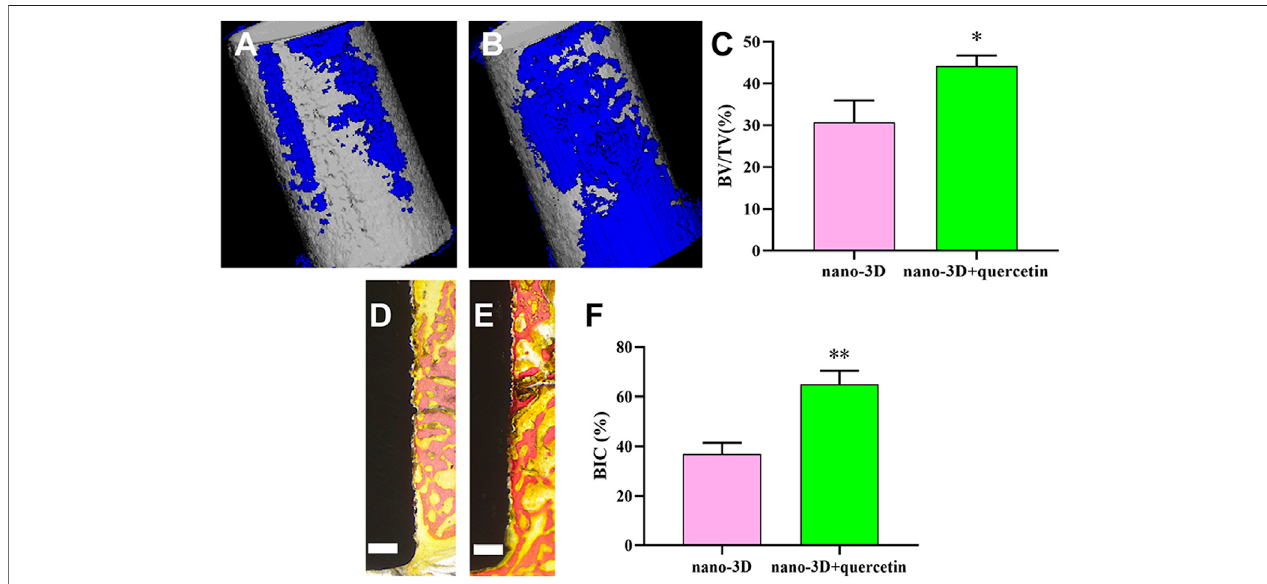
FIGURE6| 3D-reconstructedimagesofnewboneformation(blue)aroundtheimplants(grey)ofnano-3D (A) andnano-3D+quercetin (B) at4 weeks,quantitative analysis of Micro-CT data: BV/TV ratio (C) . Van Gieson staining of undecalci fi ed sections of nano-3D (D) and nano-3D + quercetin (E) at 4 weeks, scale bar = 300 μ m, and the histomorphometric analysis of BIC percentage (F) , (* p < 0.05, ** p < 0.01).